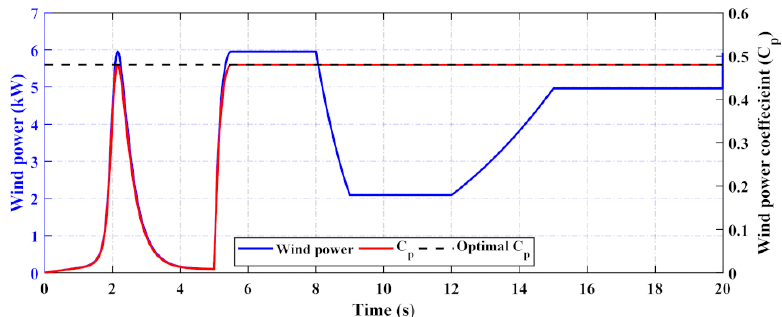
Figure 10. Wind power and its coefficient confirms the effectiveness of the WT-MPPT.